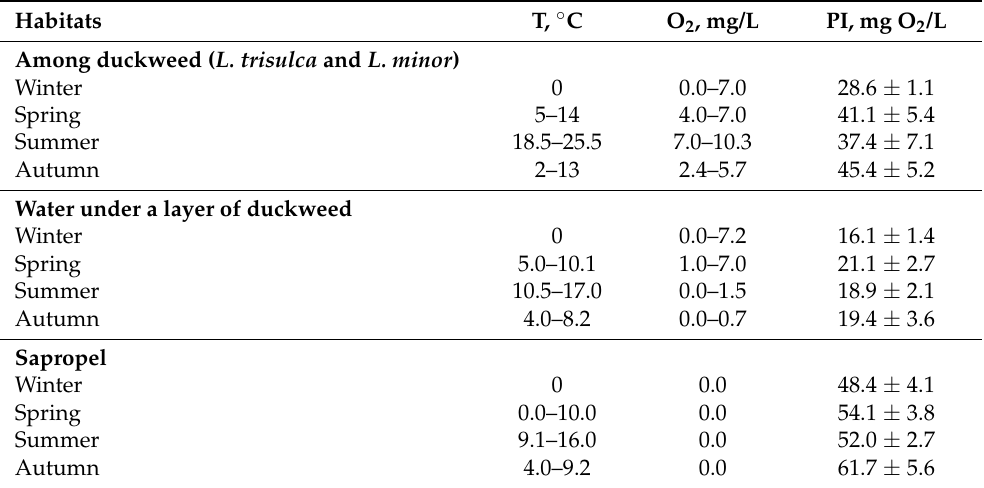
Table 2. Physical and chemical characteristics of the habitats in the lake. T—Temperature and O—dissolved content—minimum and maximum values for the season; PI—Permanganate Index—mean for the season ± SD. T, ◦ C O 2 , mg/L PI, mg O 2